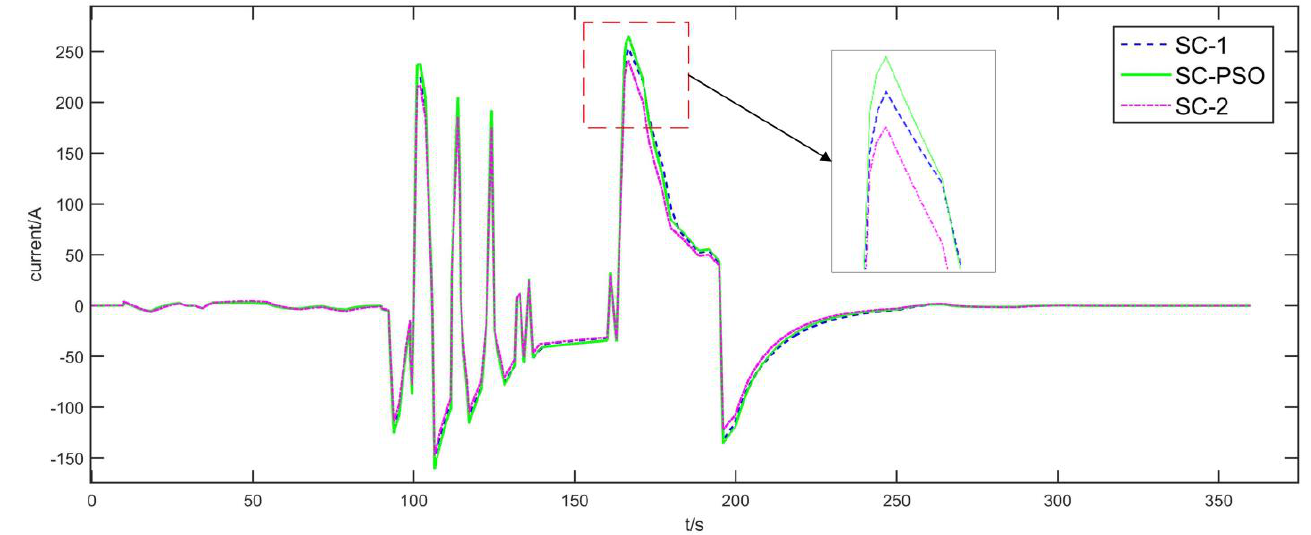
Figure 10. Supercapacitor output current under different energy management policy parameters.